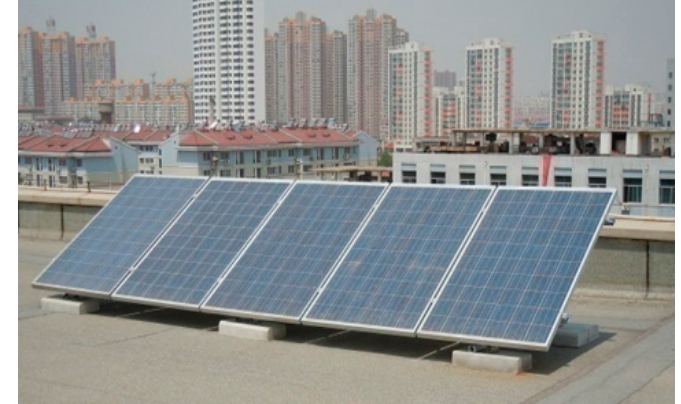
Figure 14. PV generation system for case study. Table 6. Specifications of the panels of the PV generation system.